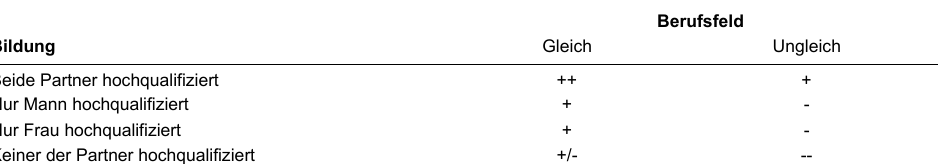
Tabelle 1 : Postulierter Zusammenhang zwischen Status-Homogamie und individuellen beruflichen